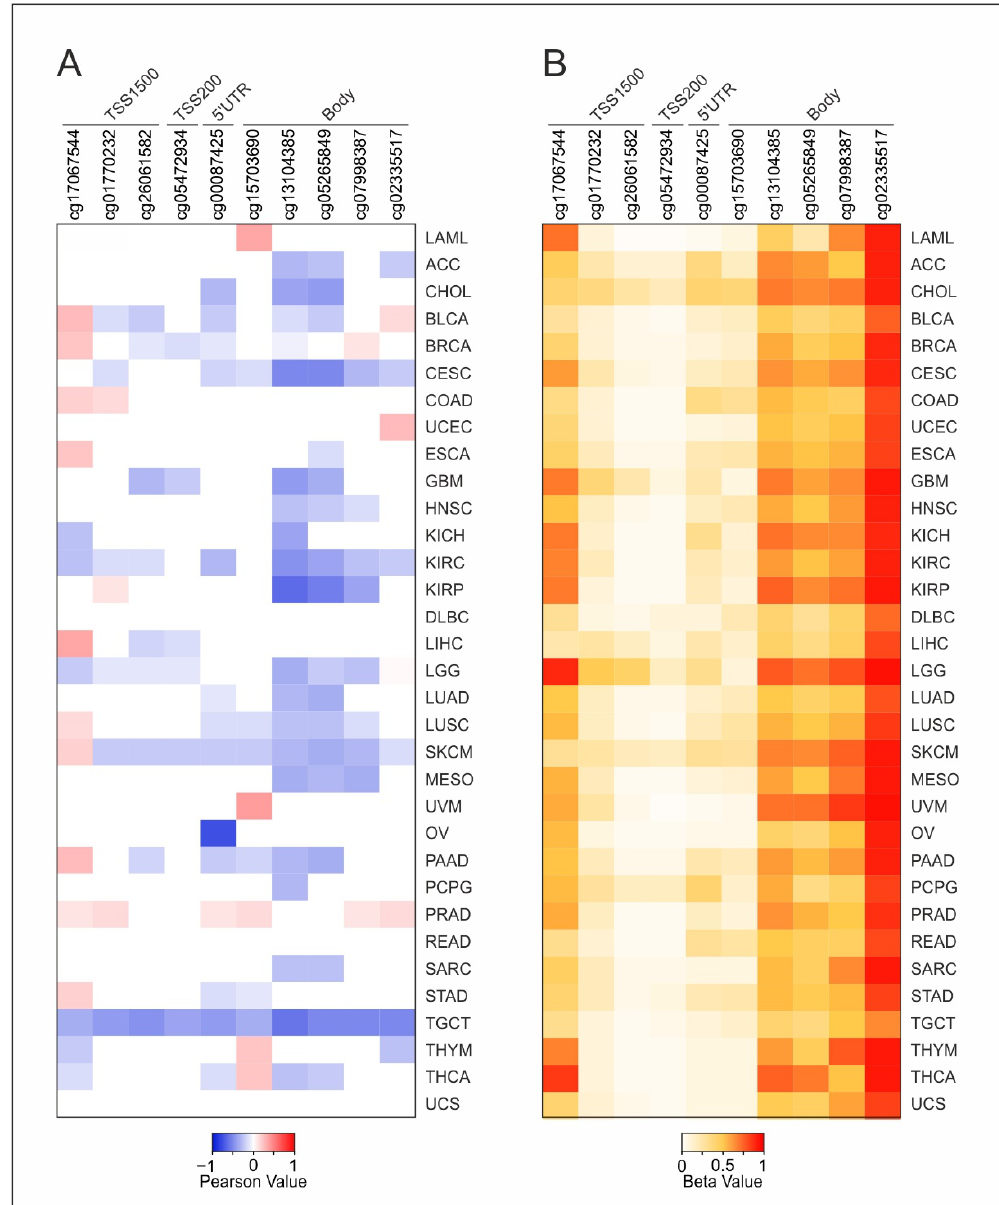
Figure 1. Correlation analysis between IL6 expression and DNA methylation for each tumor type. ( A ) The heatmap shows the significant ( p ≤ 0.05) Pearson’s correlation coefficients ≤ − 0.3 (blue) or ≥ 0.3 (red). ( B ) DNA methylation levels of IL6 CG probesets for each tumor type. The heatmap cell represents the mean values of methylation levels for each CG